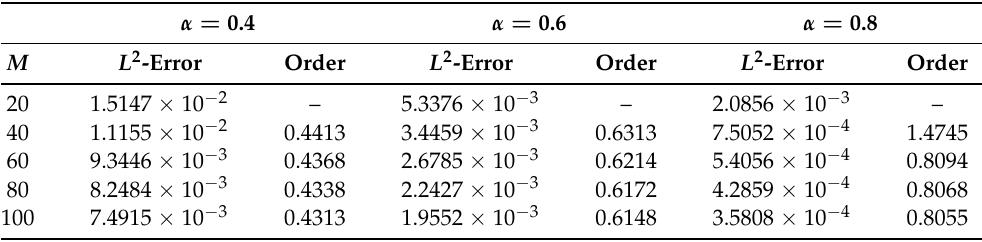
Table 5. The L 2 -norm errors and temporal convergence orders for Example 2 using scheme (48), M = N x = N y , k = 1, T = 1/4, r = 1. α =